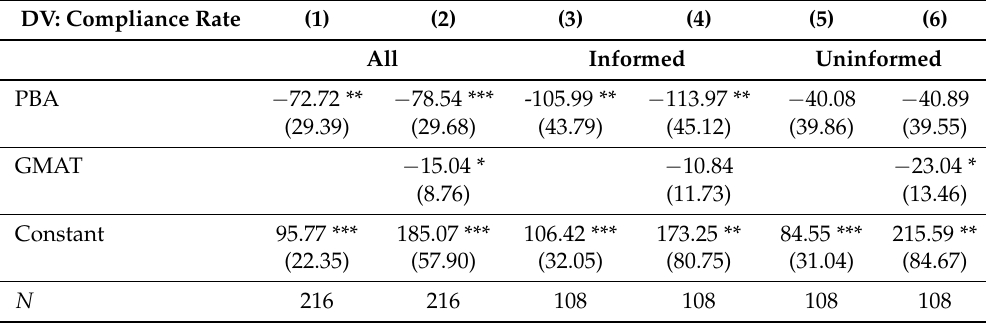
Table A8. Allocation treatment regressions (Tobit).